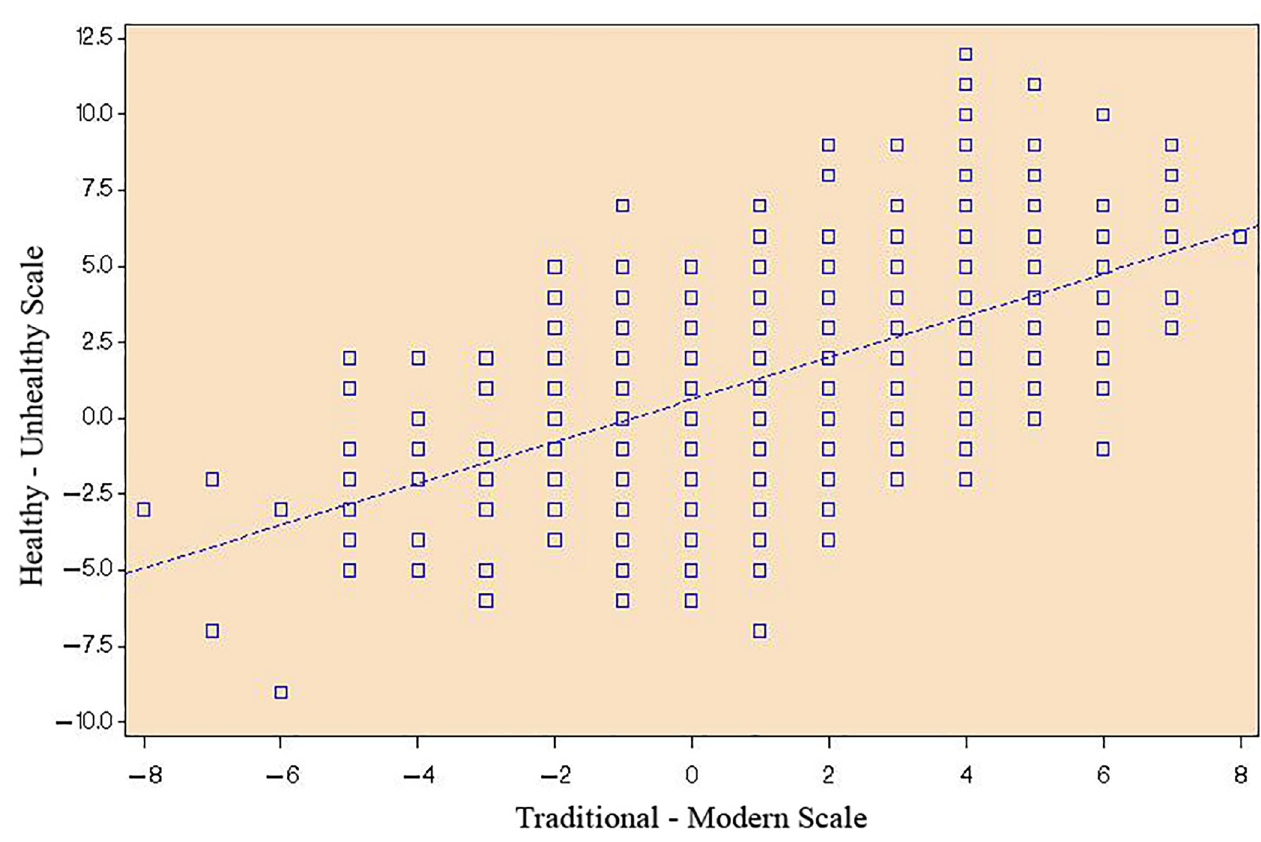
Fig 2. Plot of Traditional-Modern scale scores versus Healthy-Unhealthy scale scores. The plot shows the relationship between the Pohnpeian study participants’ scores on the Traditional-Modern scale and their scores on the Healthy-Unhealthy